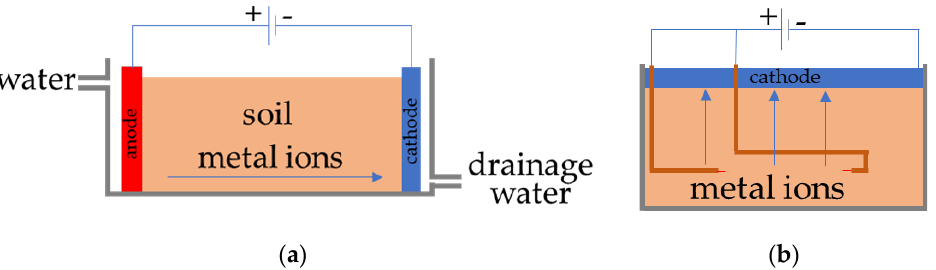
Figure 1. Diagram of electrokinetic (EK) remediation. ( a ) Conventional EK treatment. ( b ) FEM-EK treatment.